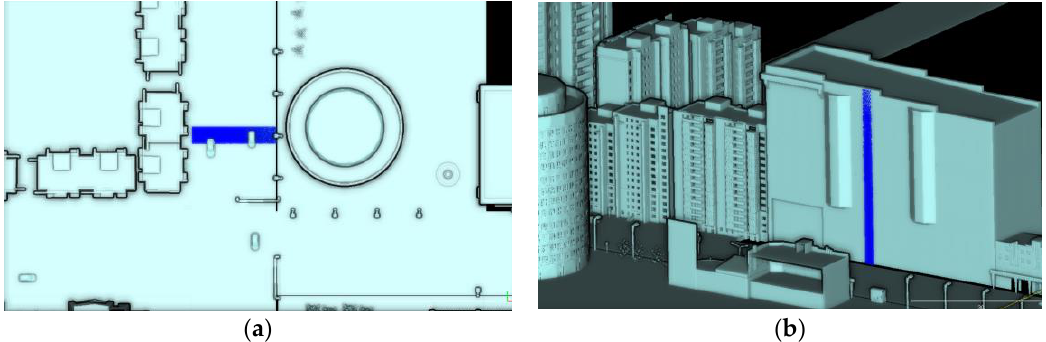
Figure 11. Selected testing point cloud slices in blue. ( a ) Ground slice. ( b ) Facade slice.